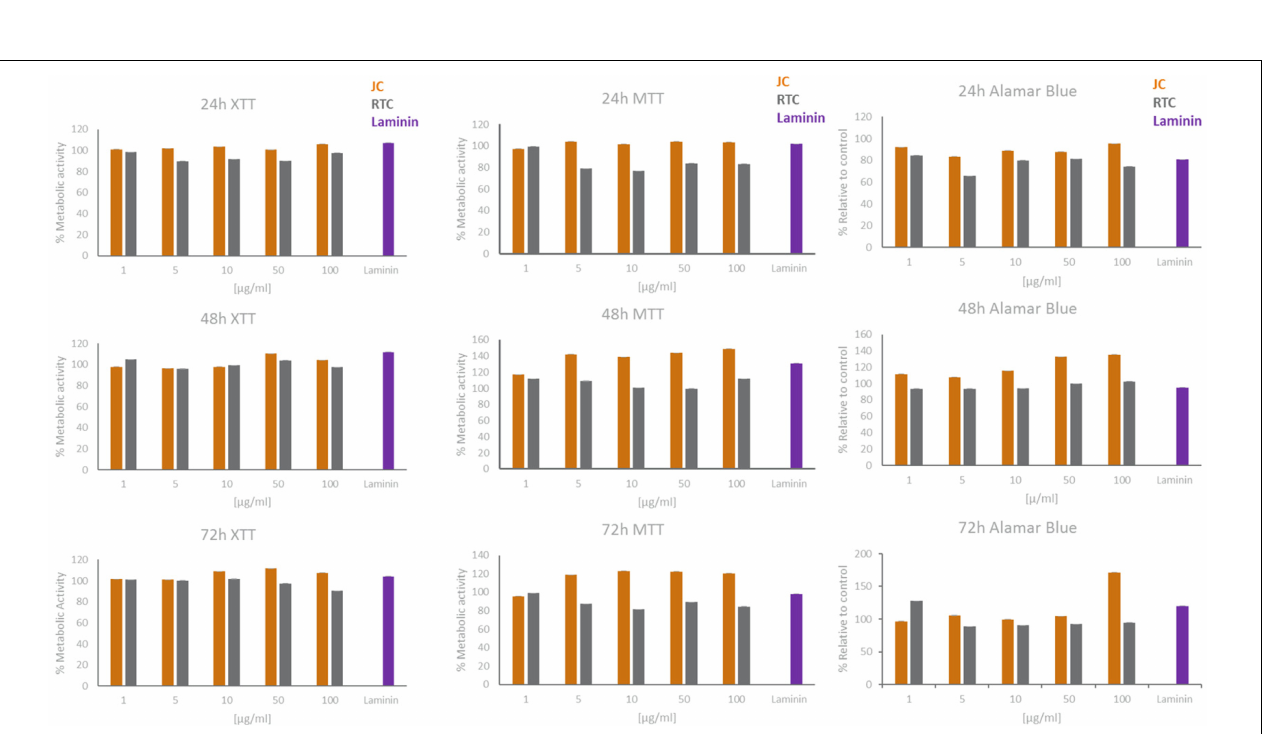
FIGURE 2 | XTT, MTT, and Alamar Blue cell viability results for microglia cultured in different concentrations of JC, RTC, laminin or plastic for 24 h, 48 h or 72 h. All data are normalised to plastic control which is set to 100% metabolic activity. Data represent mean of 3 technical repeats ± SEM.